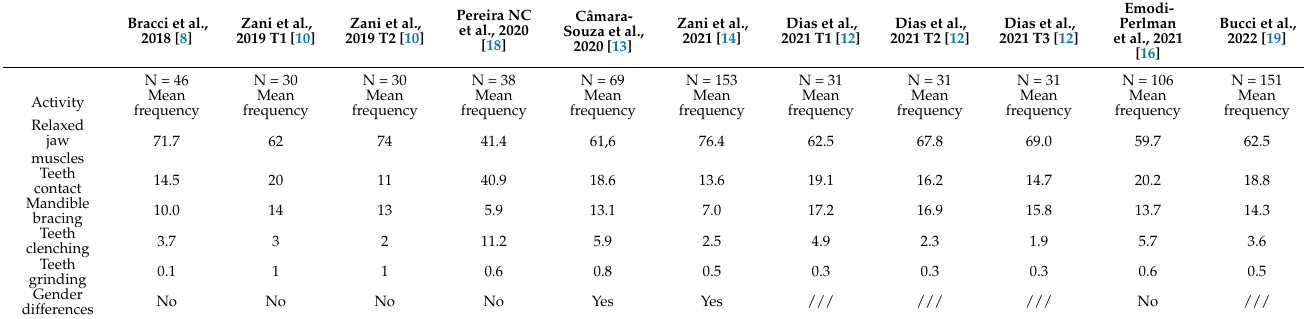
Table 2. Mean values of the frequency data (percentage of positive answers for the different AB behaviors over the 7-day observation period)—comparison among